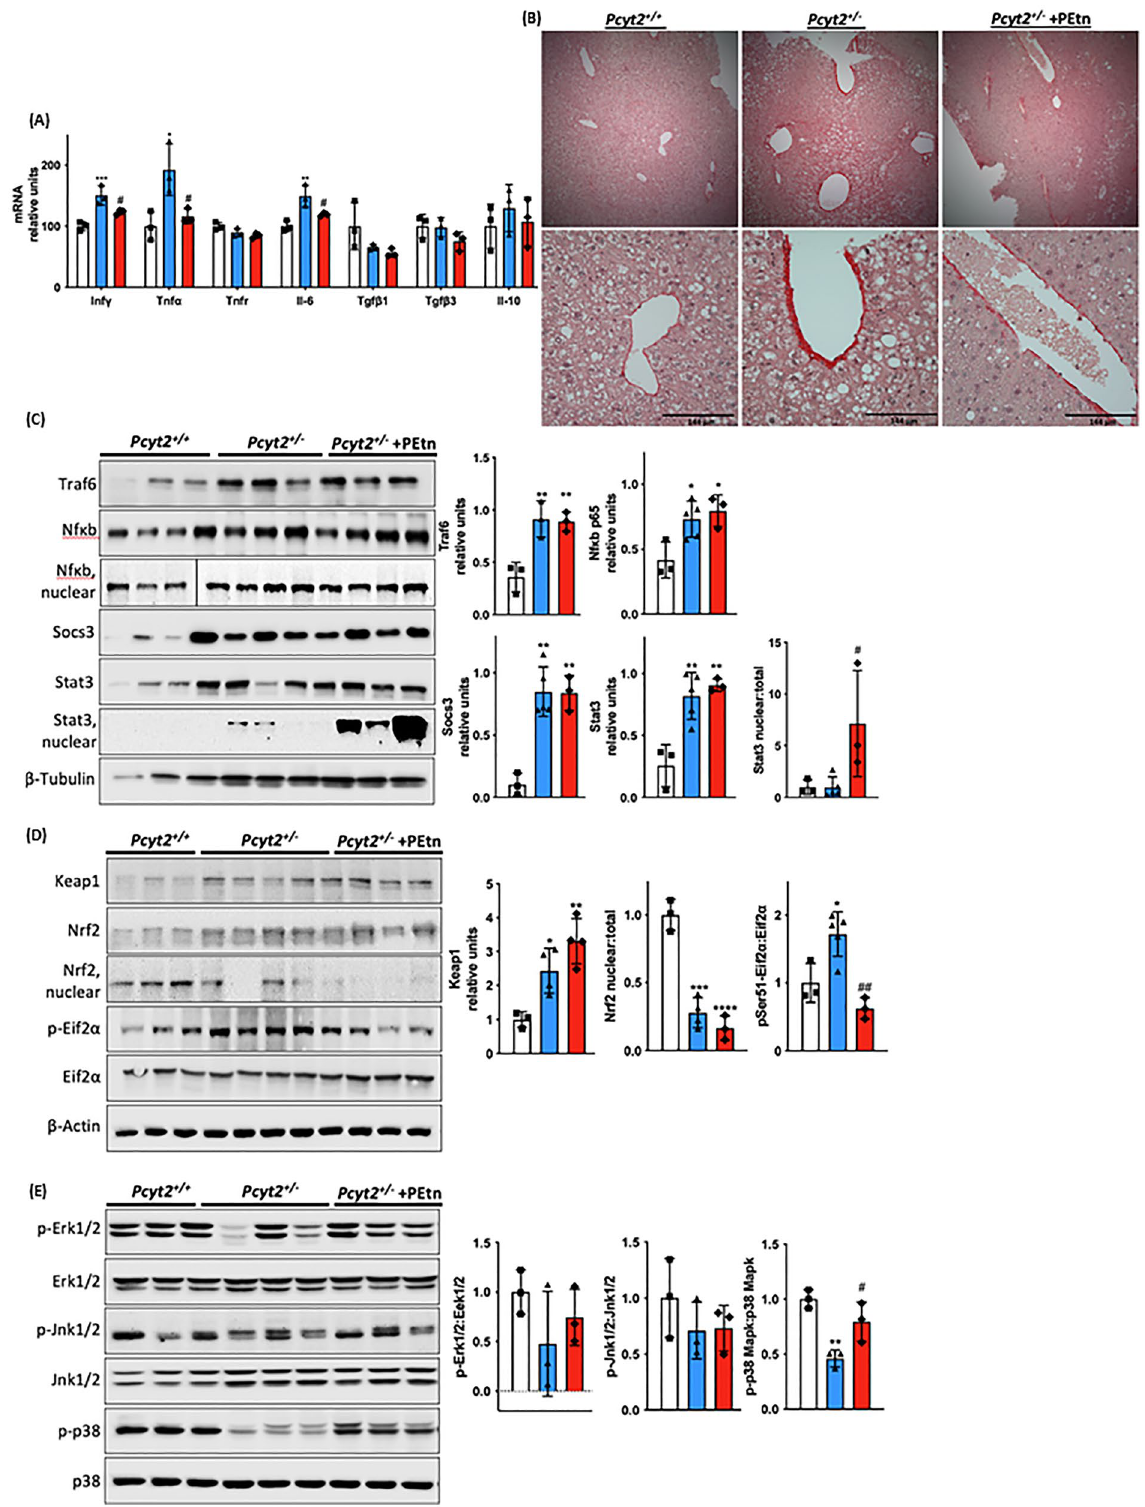
Figure 6. PEtn reduces hepatic inflammation. ( A ) mRNA expression of liver pro- and anti-inflammatory genes in 8-mo Pcyt2 + / + , Pcyt2 + /− and Pcyt2 + /− + PEtn mice treated for 12 weeks (n = 3). GAPDH used as loading control. ( B ) Picrosirius stain of showing that 8-mo Pcyt2 + /− liver have increased collagen deposition that could be reversed with PEtn. ( C ) Immunoblot analysis of transcription factors from Jak/Stat and Nfκb pathways: Traf6, Nfκb-p65, Socs3, Stat3; ( D ) Keap1/Nrf2 and pEif2α activation: Keap1, Nrf2, pSer 51 -Eif2α, Eif2α and ( E ) Stress kinases : p-Erk1/2, Erk1/2, p-Jnk1/2, Jnk1/2, p-p38 Mapk, p38 Mapk in 8-mo Pcyt2 + / + , Pcyt2 + /− and Pcyt2 + /− + PEtn mice (n = 3–4). Nfκb-p65 nuclear Pcyt2 + / + bands are from a gel separate from the Pcyt2 + /− and Pcyt2 + /− + PEtn bands, but were ran under the same conditions. Band intensities were measured using ImageJ. Membranes were cut prior to antibody hybridization to allow for the probing of multiple targets on one membrane. Data are presented as mean ± SD. * p < 0.05, ** p < 0.01, *** p < 0.001 relative to Pcyt2 + / + ; # p < 0.05, ## p < 0.01 relative to Pcyt2 + /−